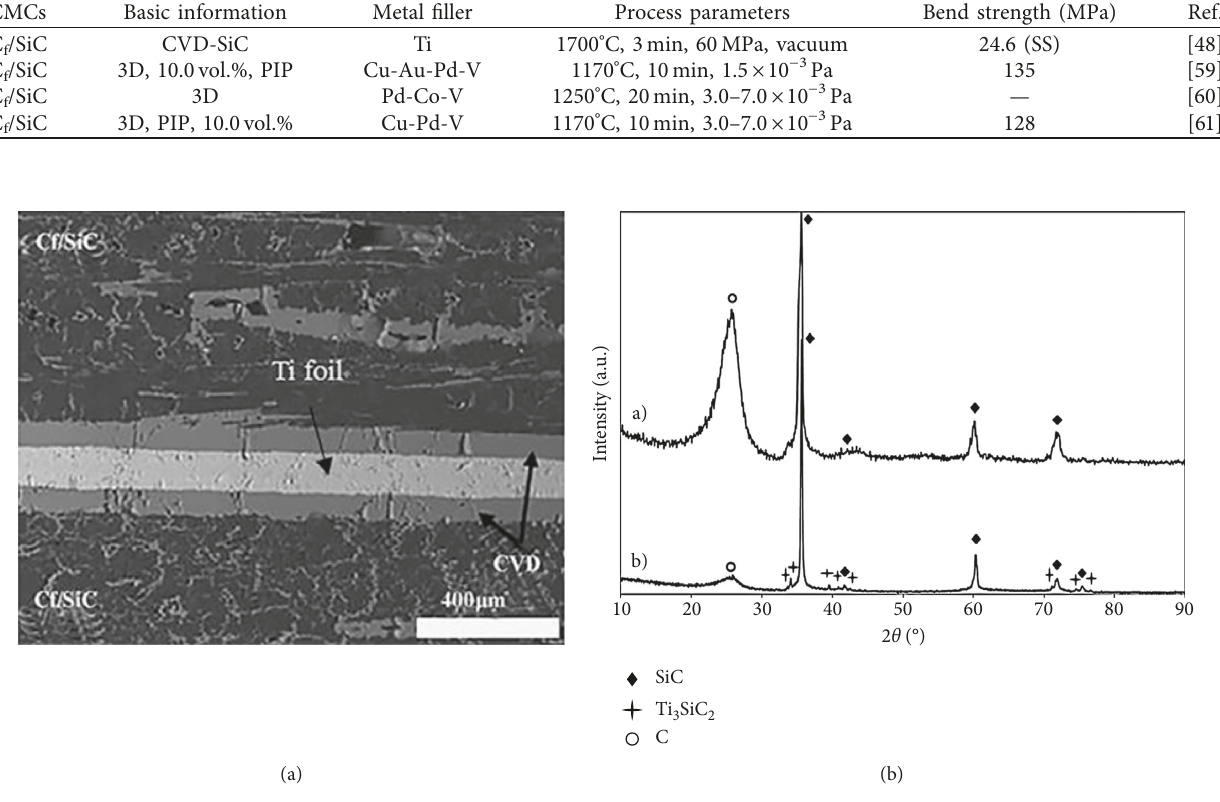
f /SiC joined by SPS